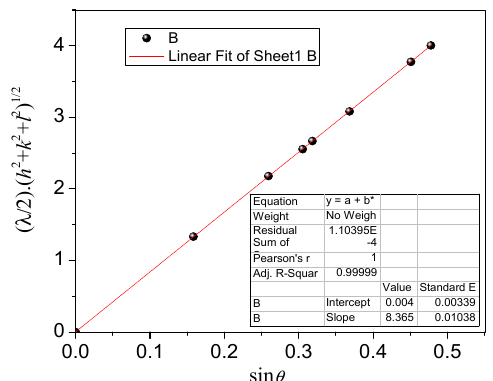
Figure 2. A plot showing the relation between the Miller indices and the angular positions of the di ff raction peaks for the spinel phase.